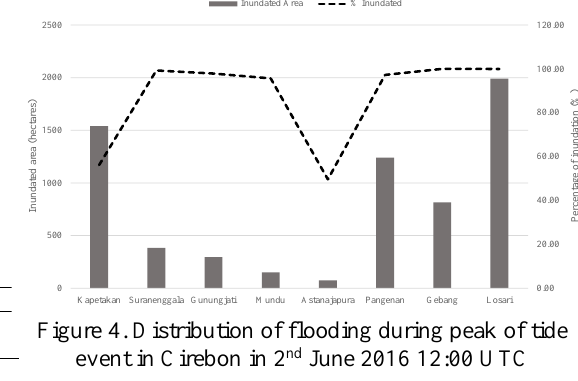
Figure 4. Distribution of flooding during peak of tide event in Cirebon in 2 nd June 2016 12:00 UTC